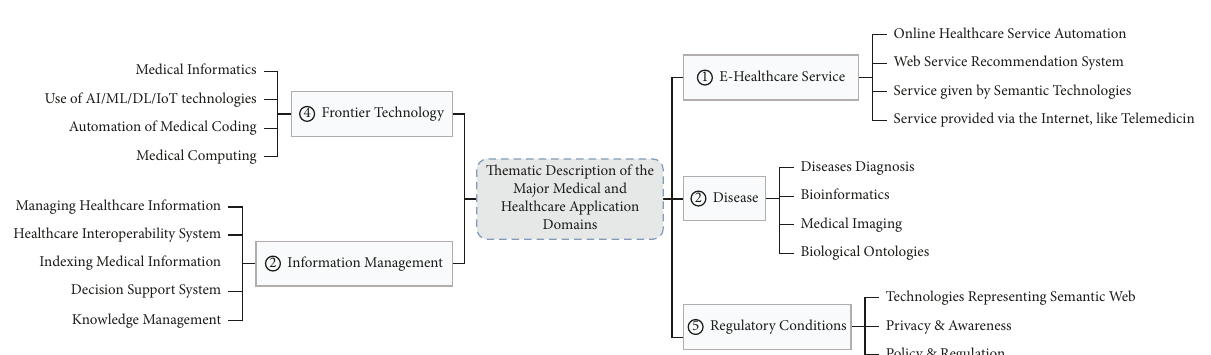
Figure 6: Thematic description of Semantic Web approaches in medical and